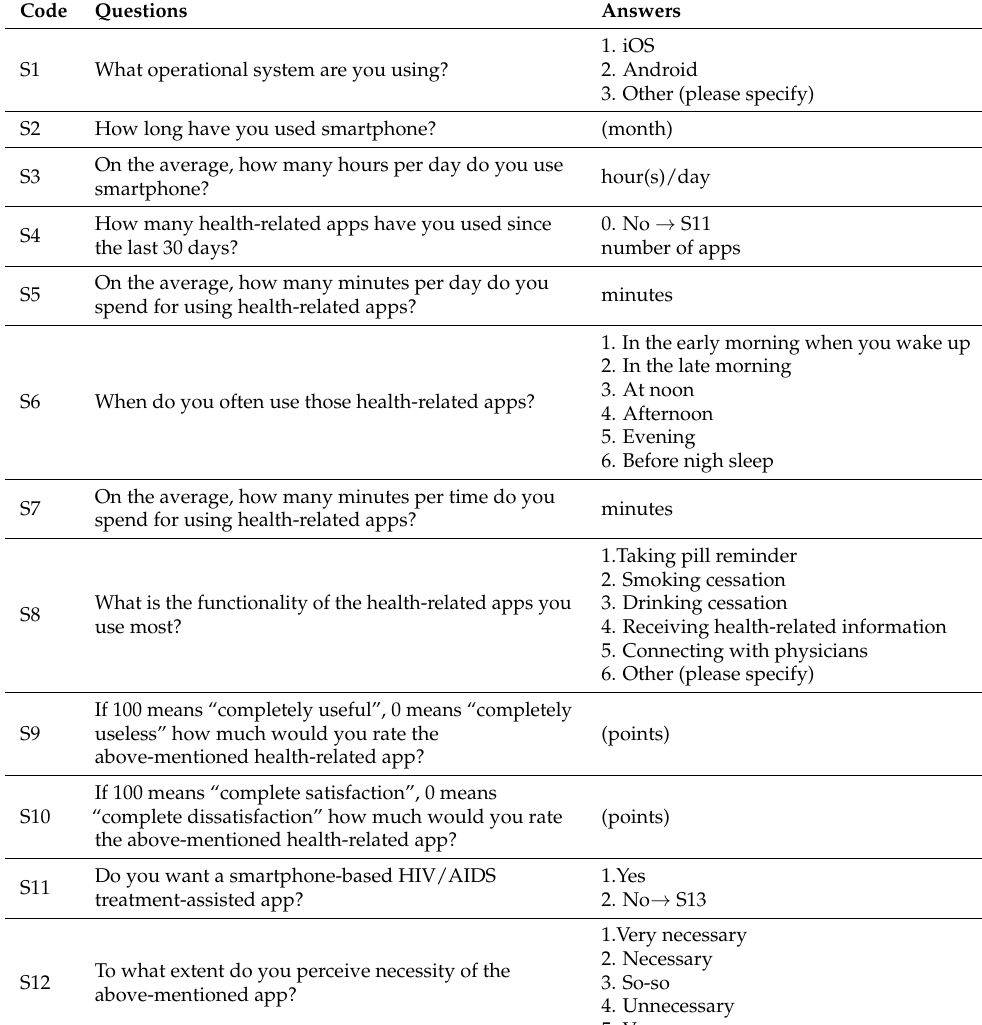
Table A1. Questionnaire for using a health-related